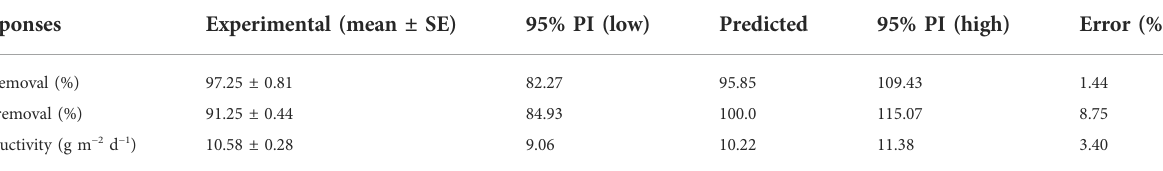
TABLE 4 Validation results under optimized growth conditions of TIC (9 mM), N:P ratio (6.04, TP 10 mg L − 1 ), and light intensity (500 μ mol photons m − 2 s − 1 ). Data are presented as mean ± standard error (SE, n = 3). TP, total phosphorus; TN, total nitrogen; PI, prediction